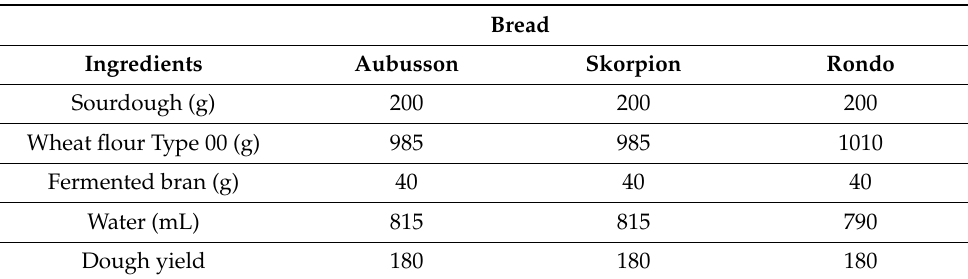
Table 1. Ingredients for bread-making. Aubusson: bread with a sourdough made with wheat flour cv Aubusson; Skorpion: dough with a sourdough made with wheat flour cv Skorpion; Rondo: dough with a sourdough made with barley flour cv